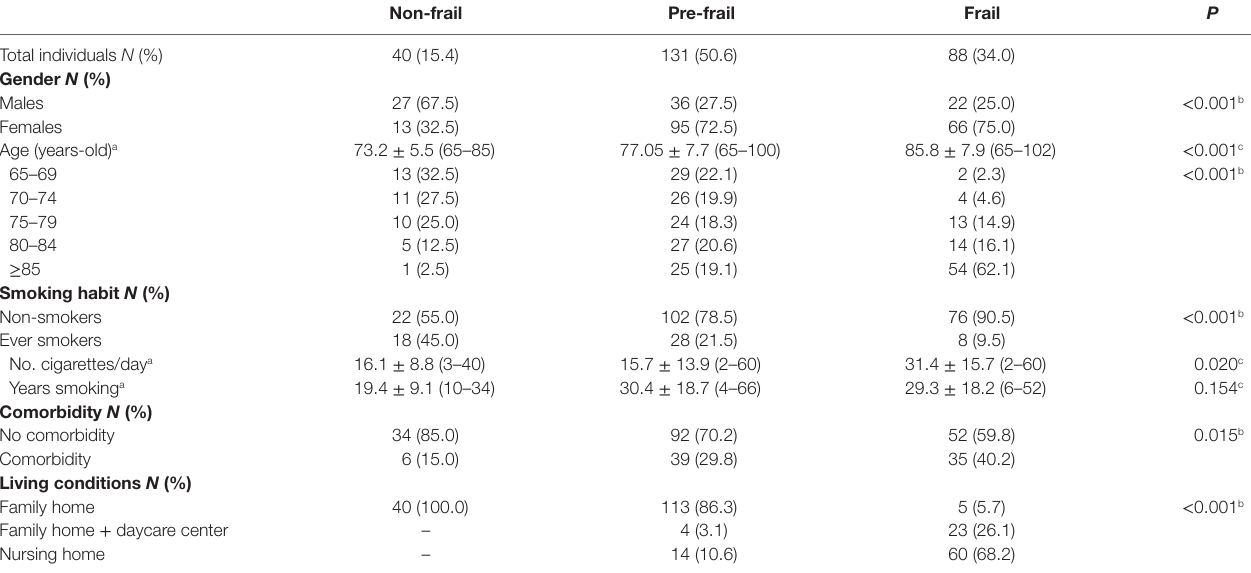
Table 1 | Description of the study population. non-frail Pre-frail